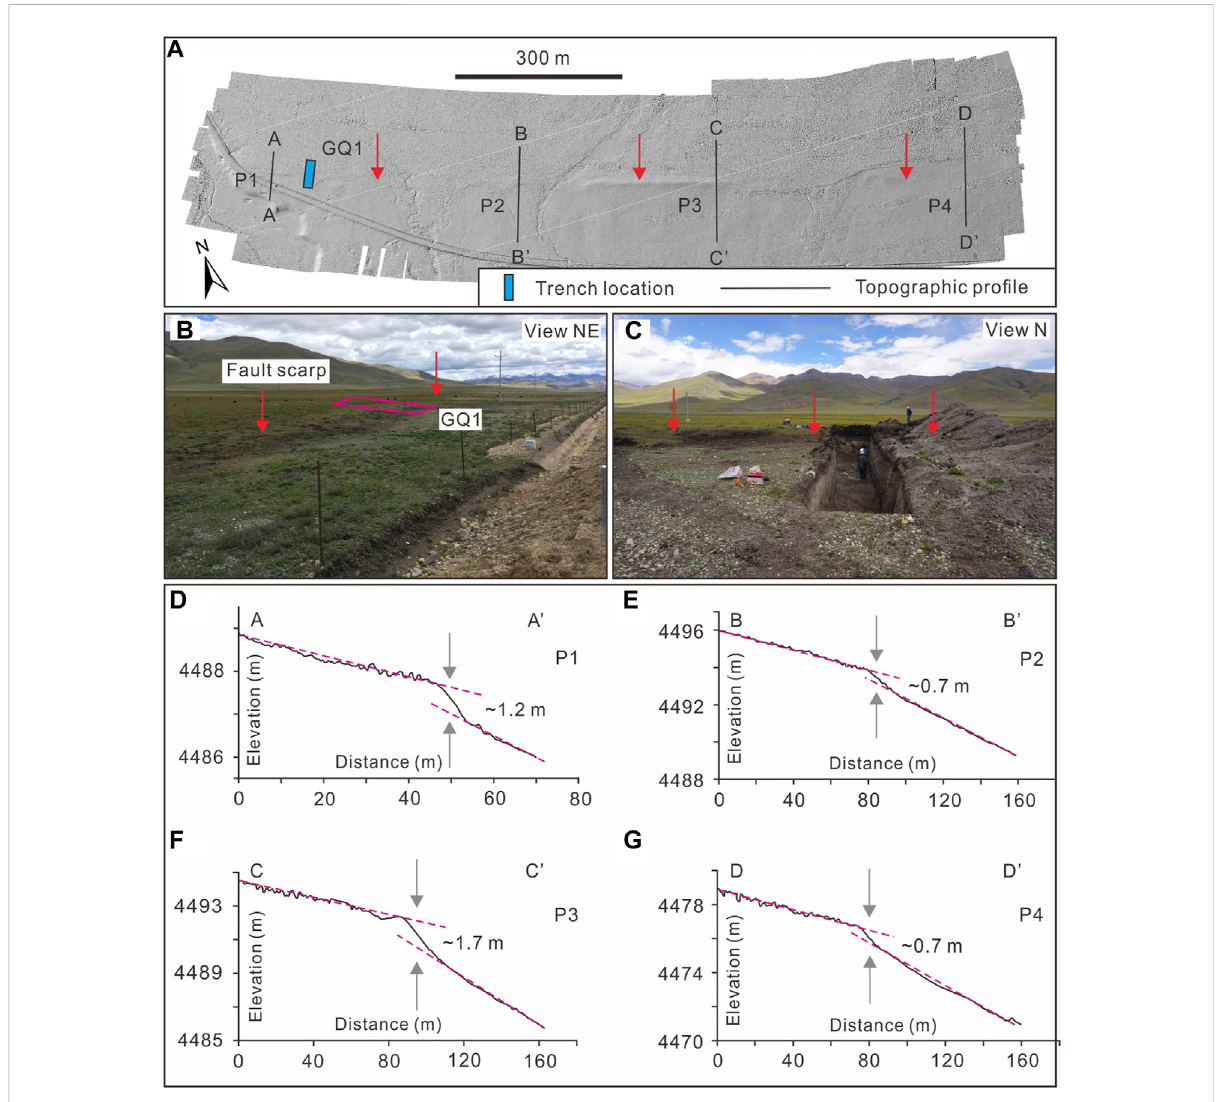
FIGURE 5 Faulted landforms around the trench GQ1 excavation site. (A) The hillshade map is generated from an unmanned aerial vehicle-based digital elevation model. The location is shown in Figure 3A. The red arrows point to the surface trace of the fault. (B,C) Field photos of the fault scarp and location of trench GQ1. (D – G) P1 – P4 topographic pro fi les across the fault